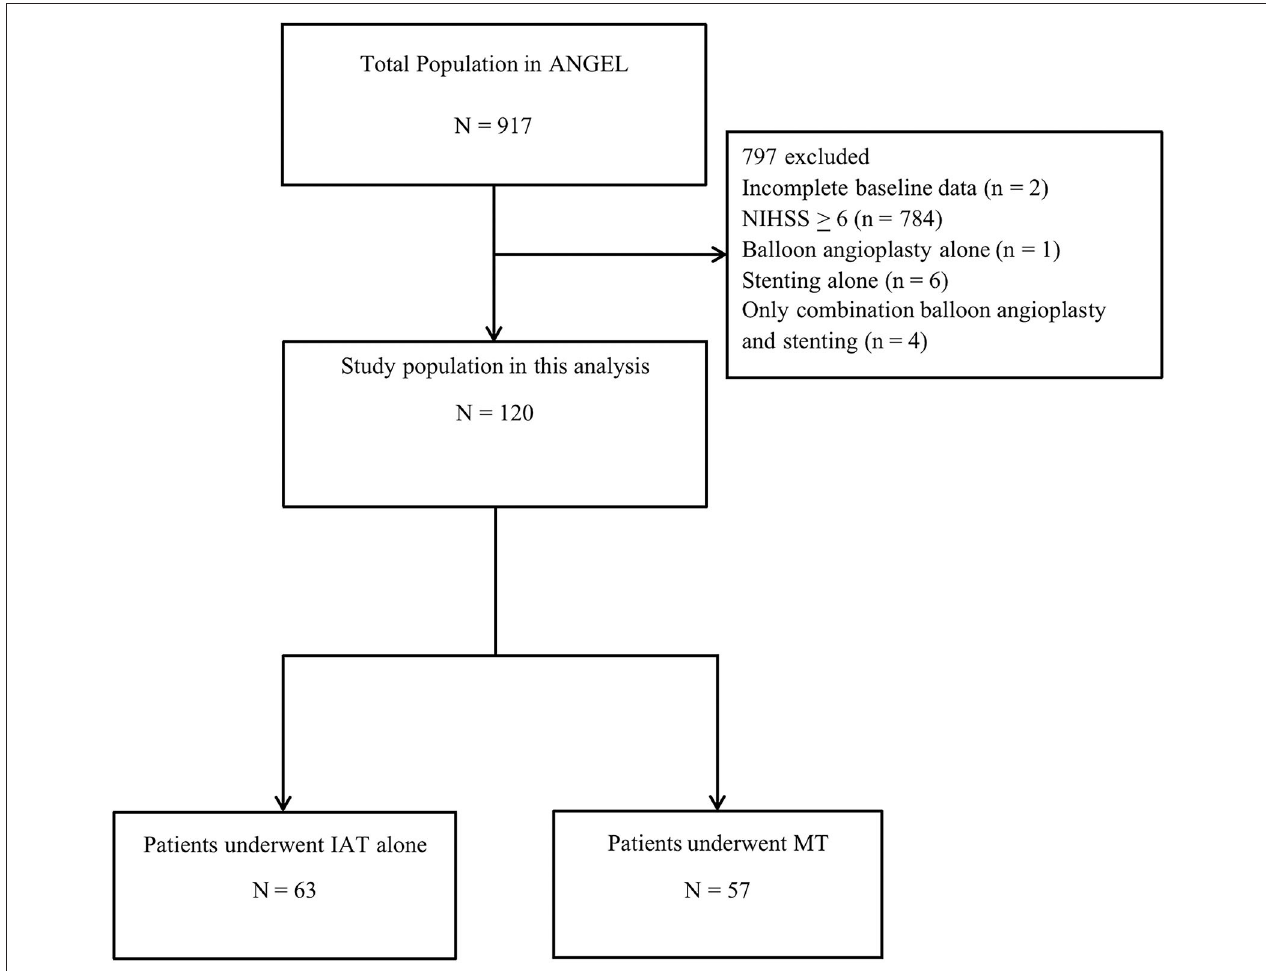
FIGURE 1 | Flow chart showing patient selection. MT, mechanical thrombectomy; IAT, intra-arterial thrombolysis; NIHSS, National Institutes of Health Stroke Scale score.